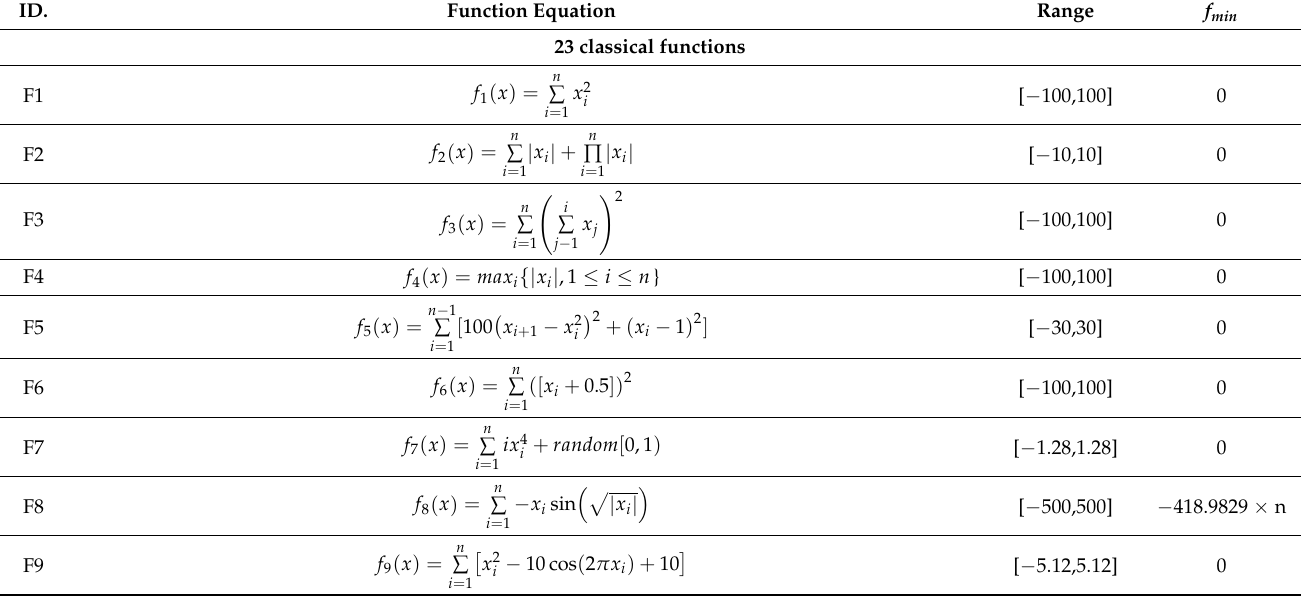
Table A3. Benchmark